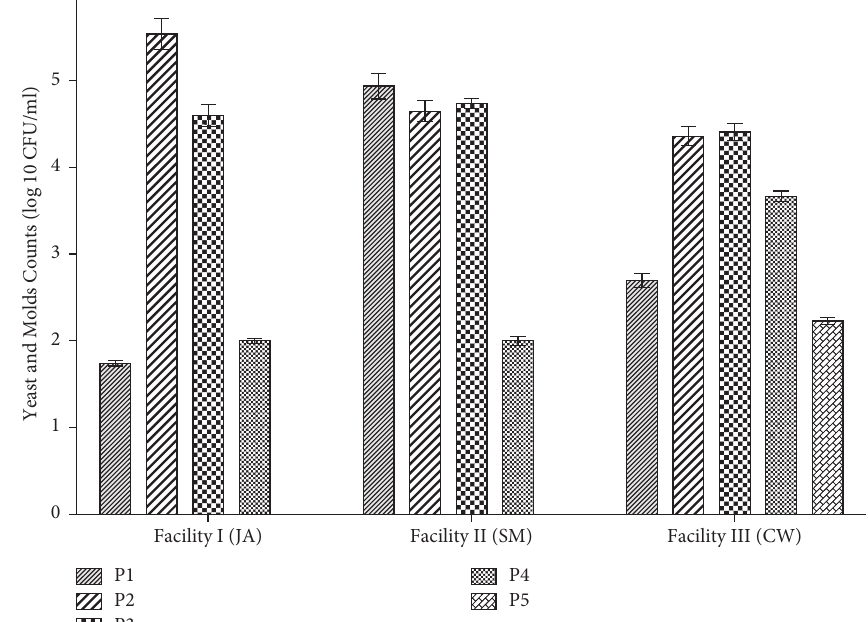
Figure 3: Yeast and moulds counts among sampling points at each processing facility. Pre-identified five different sampling points are , P ,P , P , and P , respectively; Three studied processing facilities are denoted as JA, SM, and CW. Error bars indicate denoted as P 1 2 3 4 5